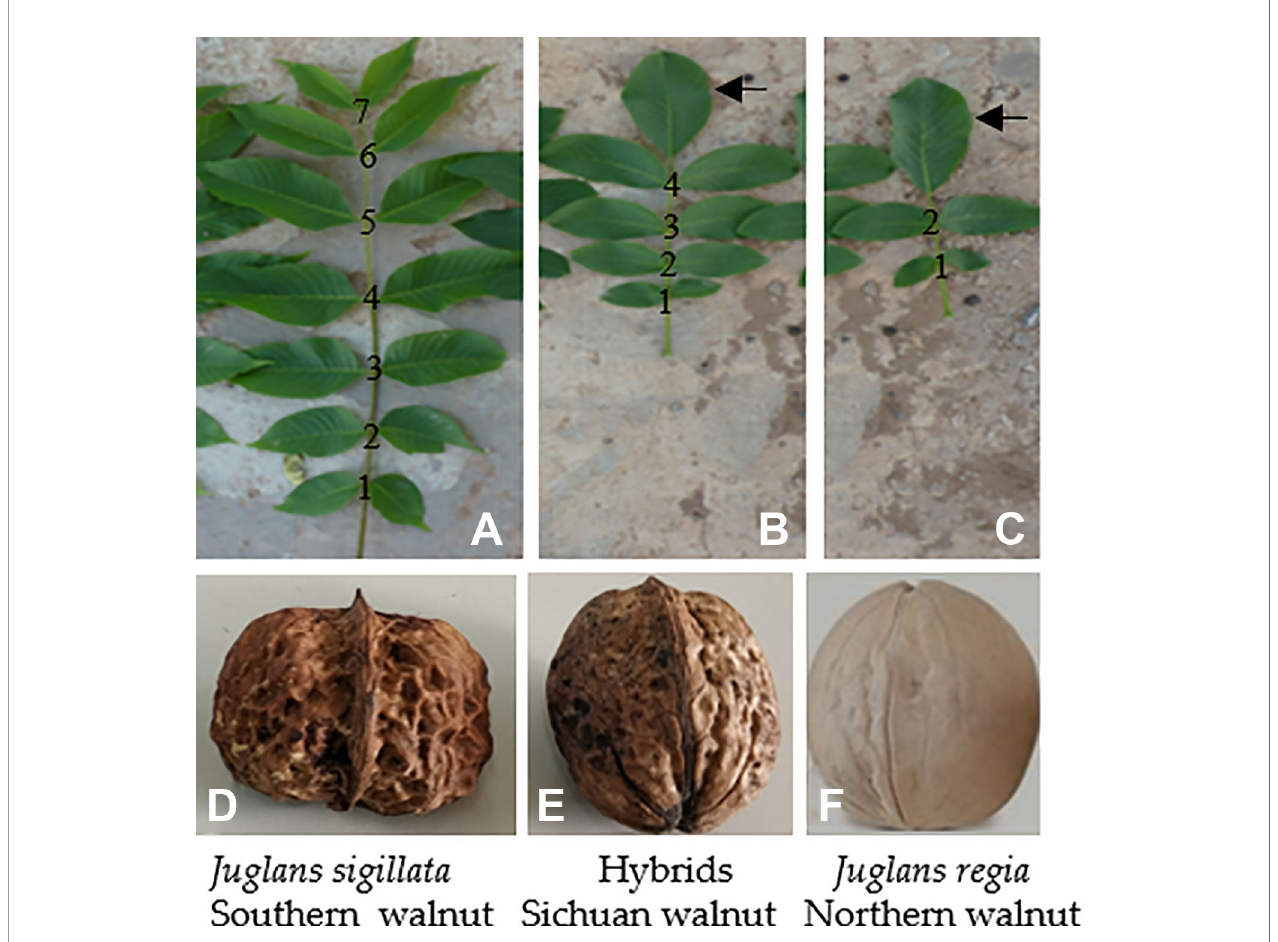
FIGURE 1 | Morphological comparison of the leaves and nuts of J. sigillata , J. regia and their hybrids. J. sigillata has more lea fl ets ( A , ~7 pairs) than J. regia ( C , ~2 pairs), and their hybrids usually have ~4 pairs of lea fl ets (B) . The compound leaf of J. sigillata (A) has a small, double parietal lobe, while that of J. regia and the hybrids (B, C) commonly has a large, single parietal lobe (arrowed). The walnut shell of J. sigillata has a deep texture (D) , while that of J. regia has little texture or may even be fl at (F) ; the shells of the hybrids have intermediate textures (E)